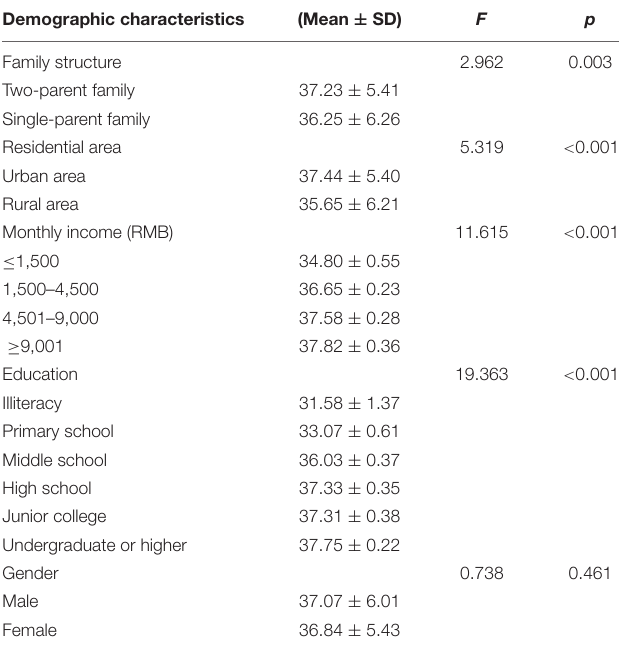
TABLE 2 | Comparison of health literacy between demographic characteristics ( N = 1,406). Demographic